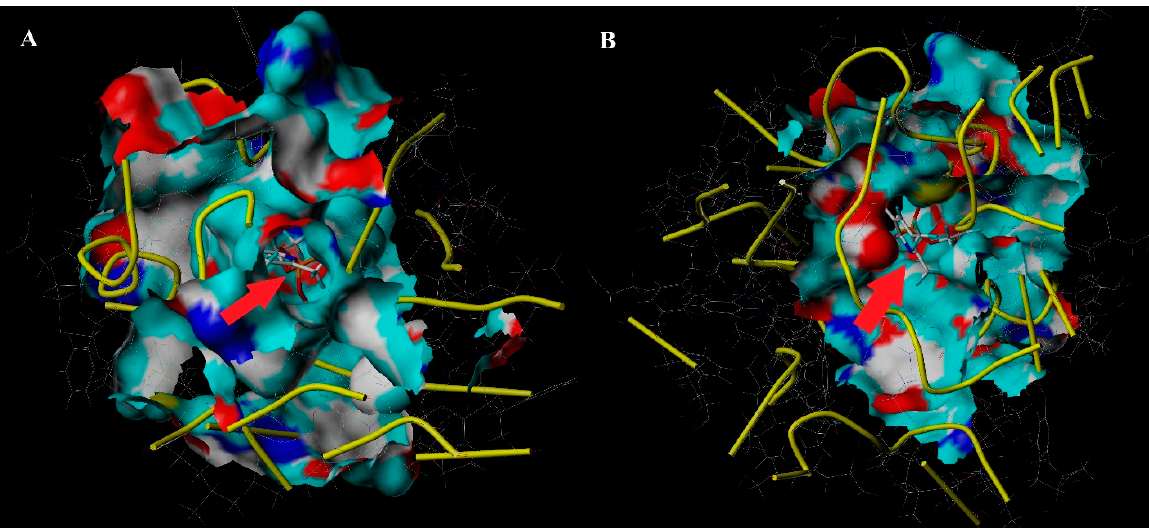
Figure 4. The docking structure with chlorpyrifos of CYP6CS3 and CYP408A3 . ( A ) CYP6CS3 domain and chlorpyrifos. ( B ) CYP408A3 domain and chlorpyrifos. The molecular cartoons were drawn with PyMol 2.3.4 software. The molecular model of chlorpyrifos was embedded in the active cavity of the P450 protein molecule, and the size of the opening of the active cavity affected the metabolic activity of the corresponding P450 protein (the active cavity is indicated by the red arrow).